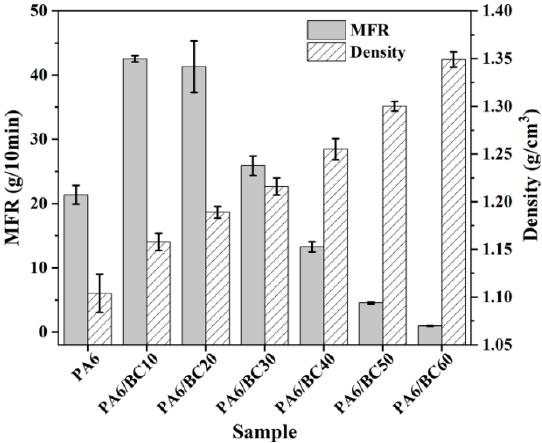
Figure 2. Melt mass-flow rate (MFR) and density of PA6/BC composites.